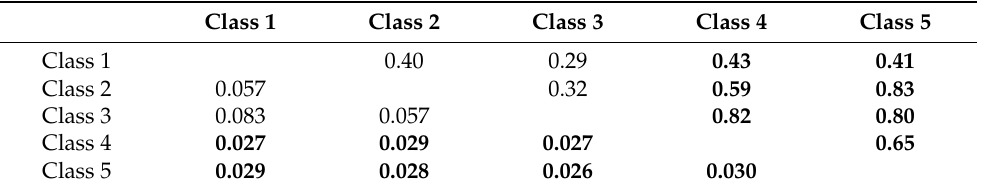
Table 3. Values of ANOSIM statistic R (upper right side) and P significant values (lower left side) of ciliate 18S rDNA gene-DGGEs from the five black pine deadwood decay classes collected in the Pratomagno study area. Bold type character indicates significant differences for p < 0.05.